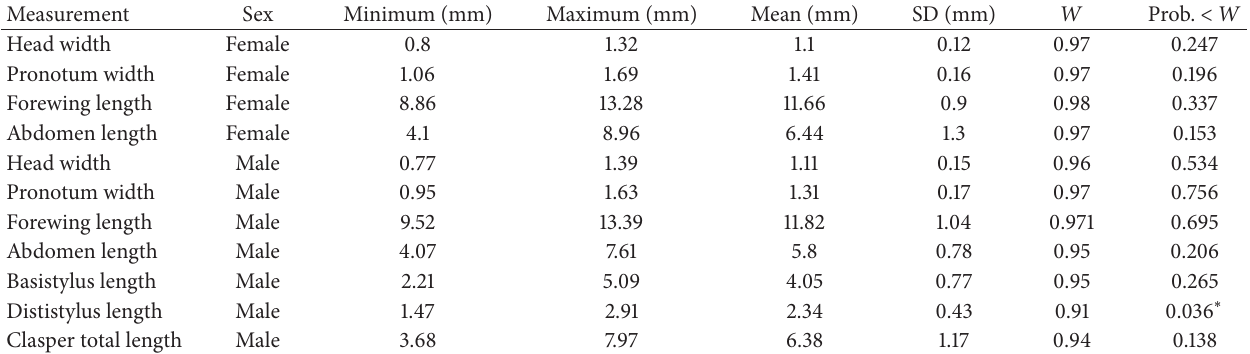
Table 2: Minimum, maximum, and mean measurements of various body parts and results of Shapiro-Wilk goodness-of-fit tests on the same. 𝑃 < 0.05 is considered significant. Significant values are indicated by an asterisk ( ∗